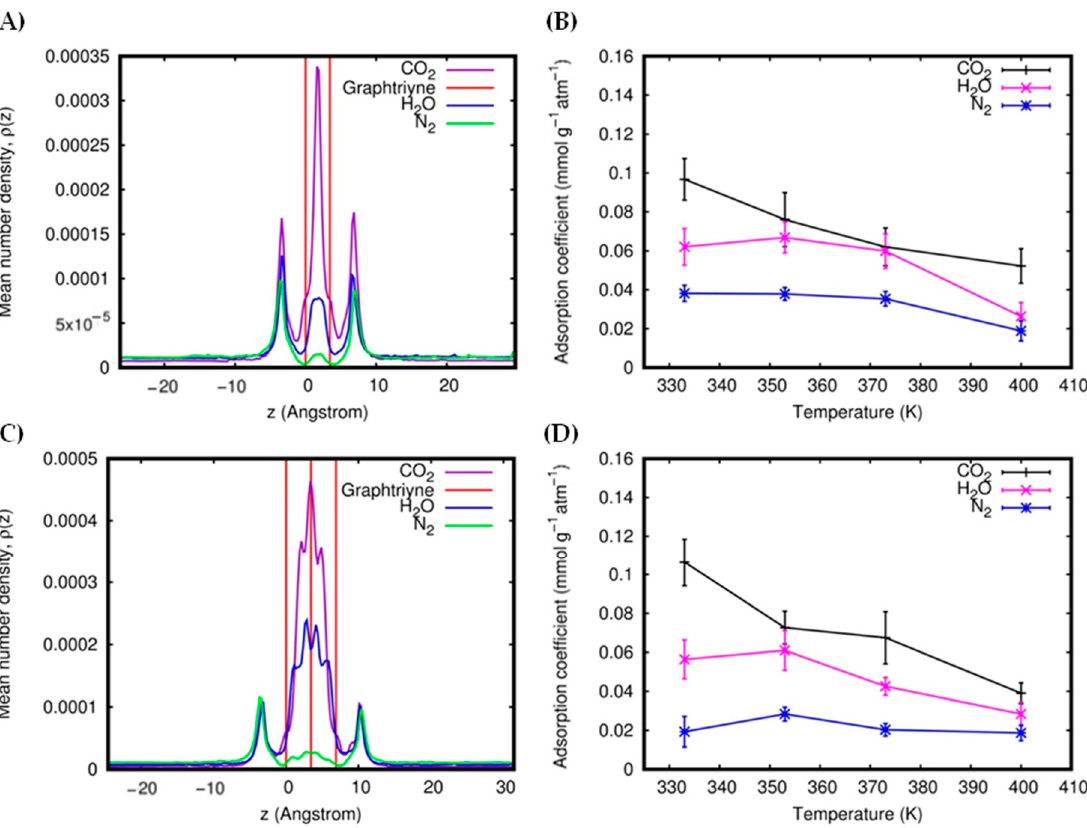
Figure 9. z -Density profiles at 1.8 atm and 353 K for bilayer ( A ) and trilayer ( C ) membranes. Adsorption coefficient as a function of temperature for bilayer ( B ) and trilayer ( D ) membranes.